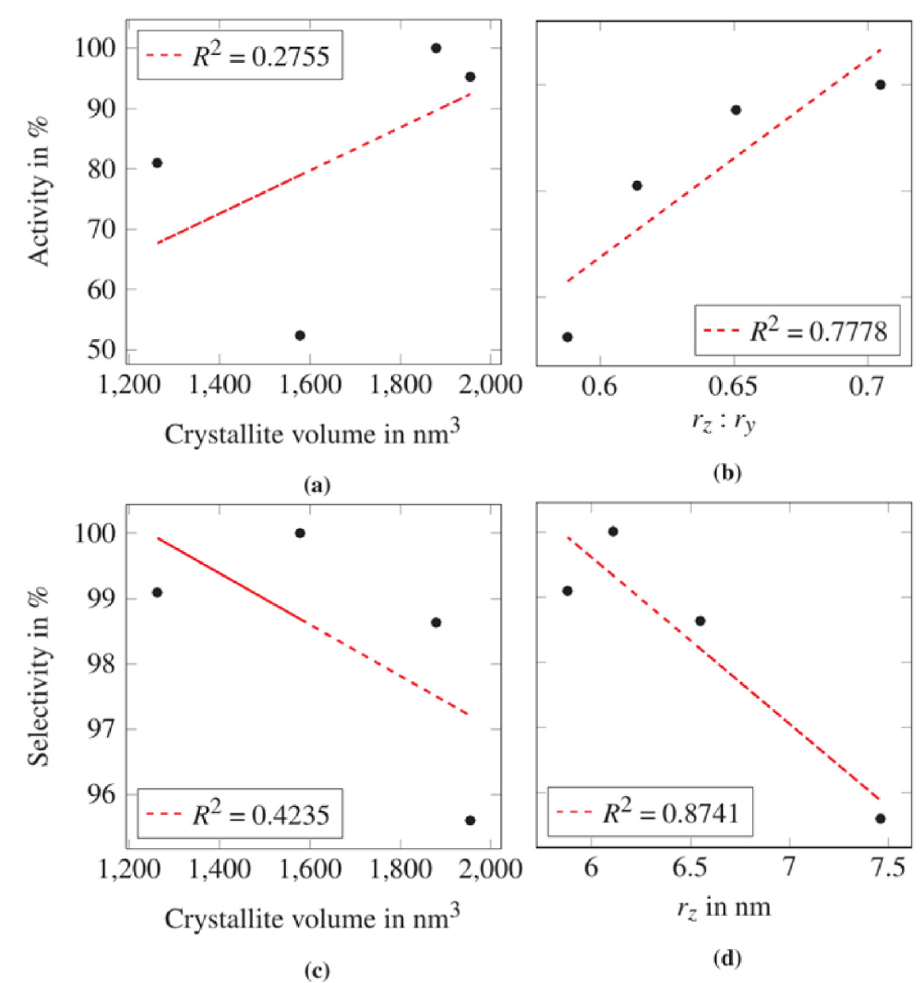
Figure 4. Correlation plots based on values gained by full profile refinement of XRD data collected after the catalytic test showing the correlation between the ( a ) catalysts’ normalized activity and the volume of coherently scattering domains, ( b ) catalysts’ normalized activity and the ratio of r z to r y , ( c ) catalysts’ normalized selectivity and the volume of coherently scattering domains and ( d ) catalysts’ normalized activity and the absolute value of r z . The broken red line is the calculated linear regression line with R 2 as the corresponding coefficient of determination.